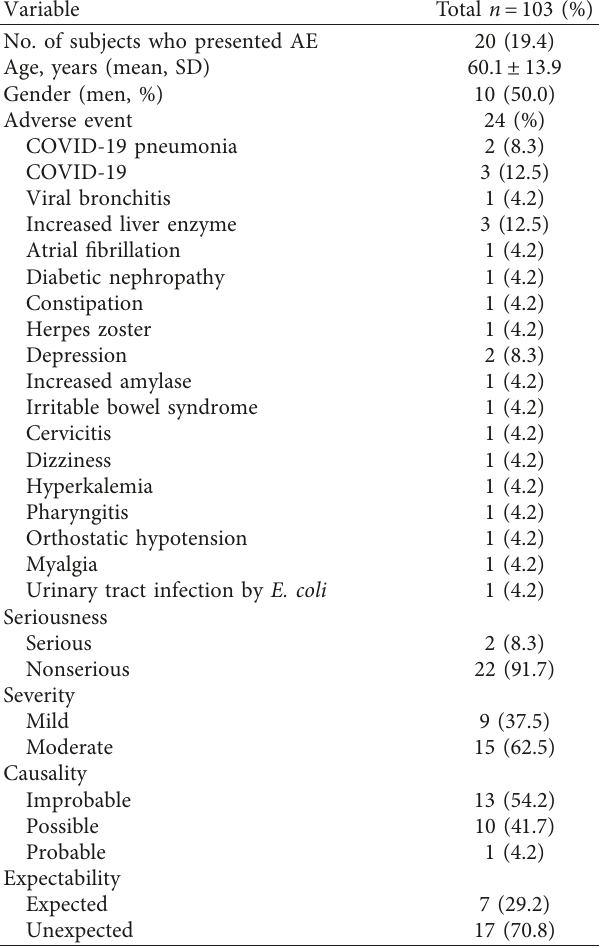
Table 6: Description of patients and adverse events displayed during the